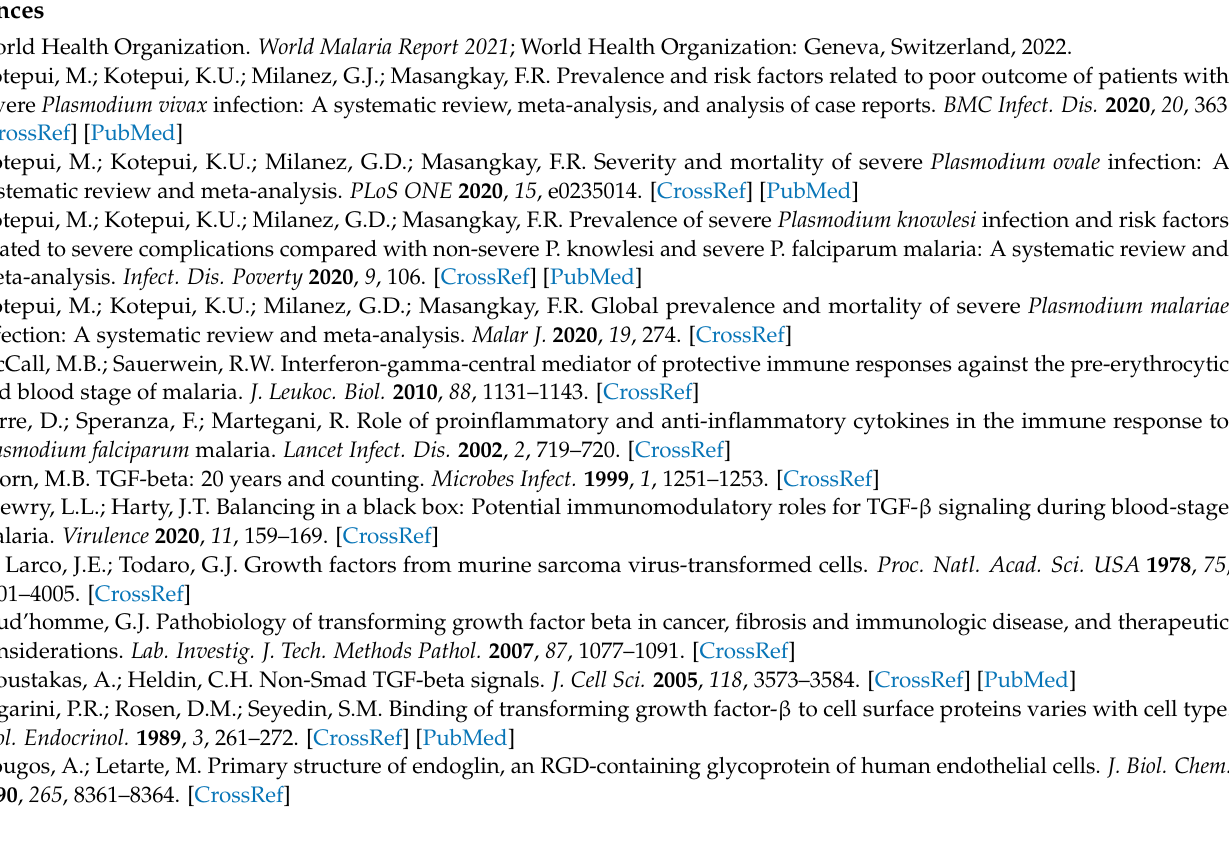
vs controls; Figure S2: Uncomplicated Pv adults vs controls; Figure S3: Severe vs uncomplicated Pf children; Table S1: Search term; Table S2: Details of the included studies; Table S3: Quality of the included